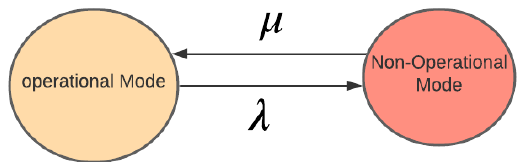
Figure 2. State space model of a repairable component.